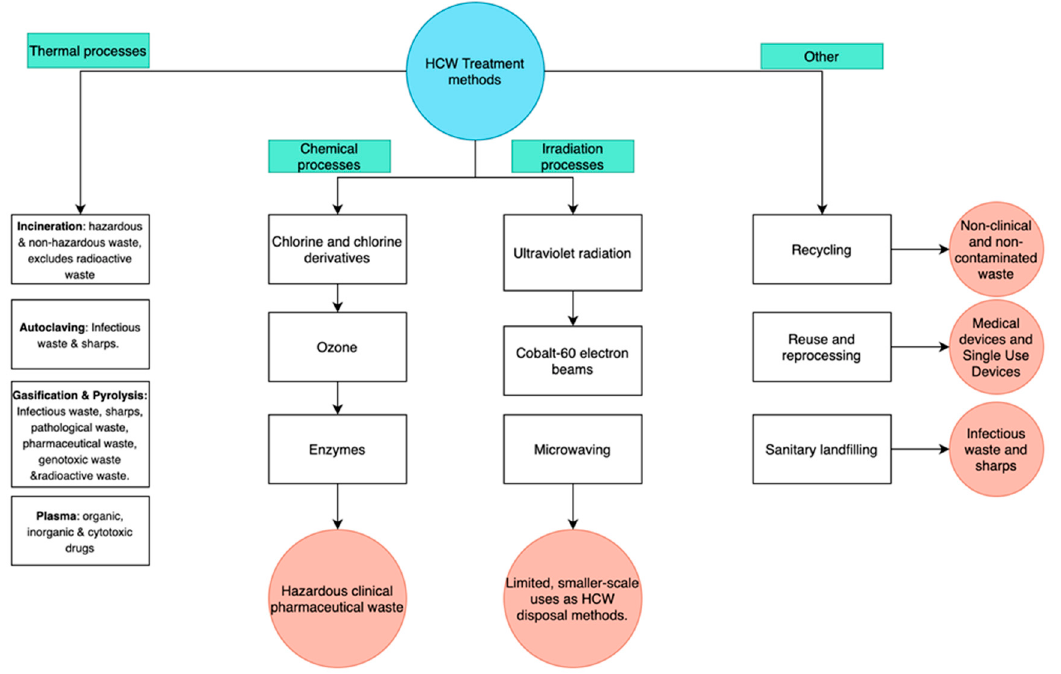
Figure 2. Categories of HCW methods.